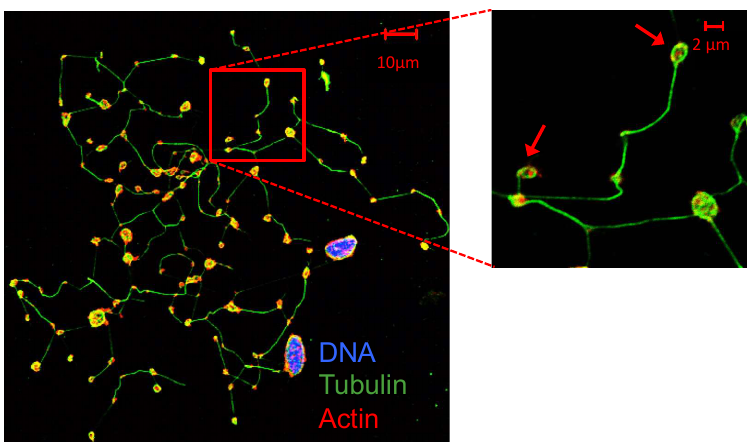
Figure 1. Megakaryocytes and proplatelets [37]. Human primary megakaryocytes and proplatelets derived from CD34 + hematopoietic stem cells progenitors obtained from cord blood (CB). At day 14 of culture, megakaryocytes show proplatelet (pointed with arrows) formation. DNA (DAPI, purple-blue), α-tubulin (green) and actin (red) staining.